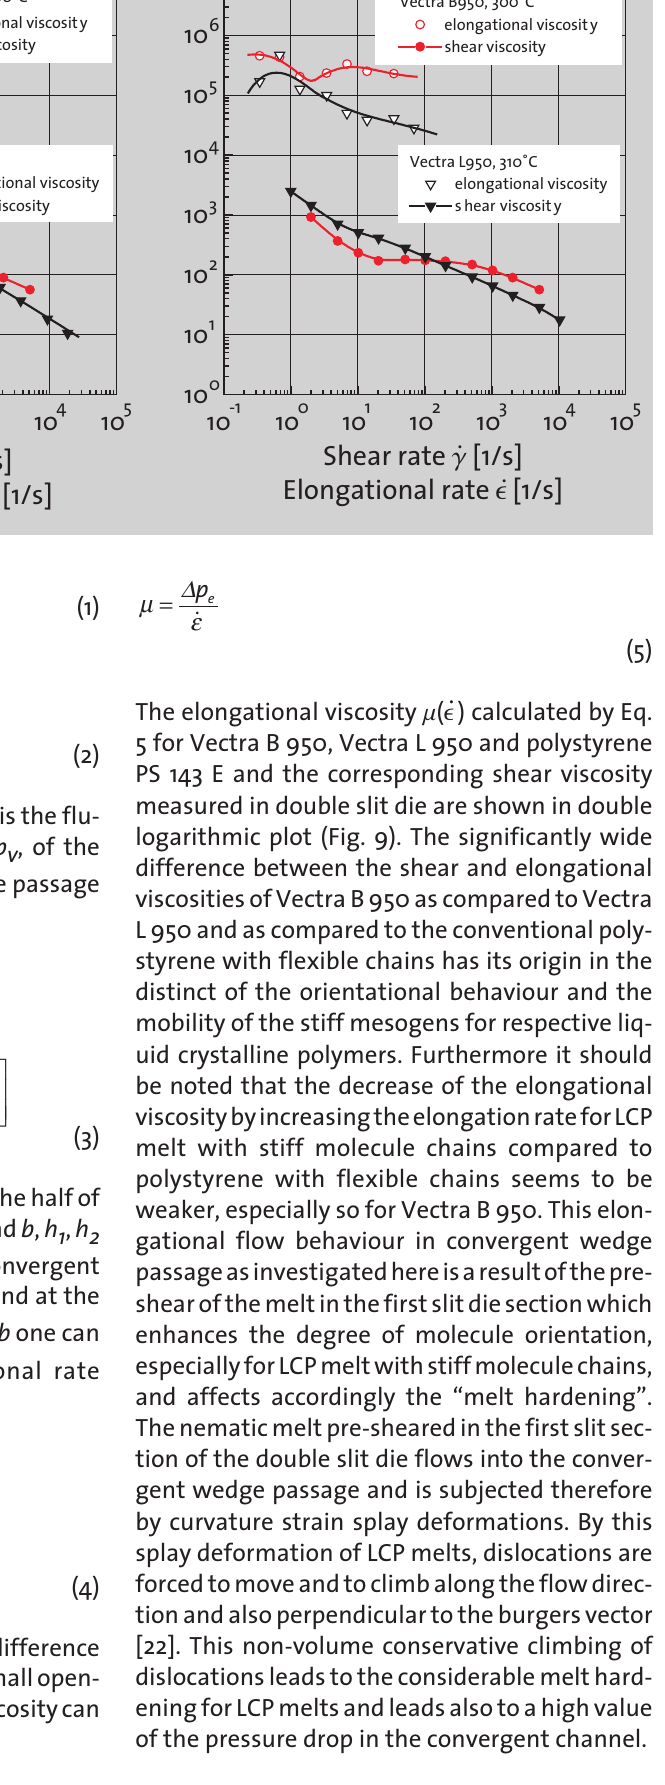
Figure 9: Shear and elongational viscosities of Vectra B 950, Vectra L 950 and